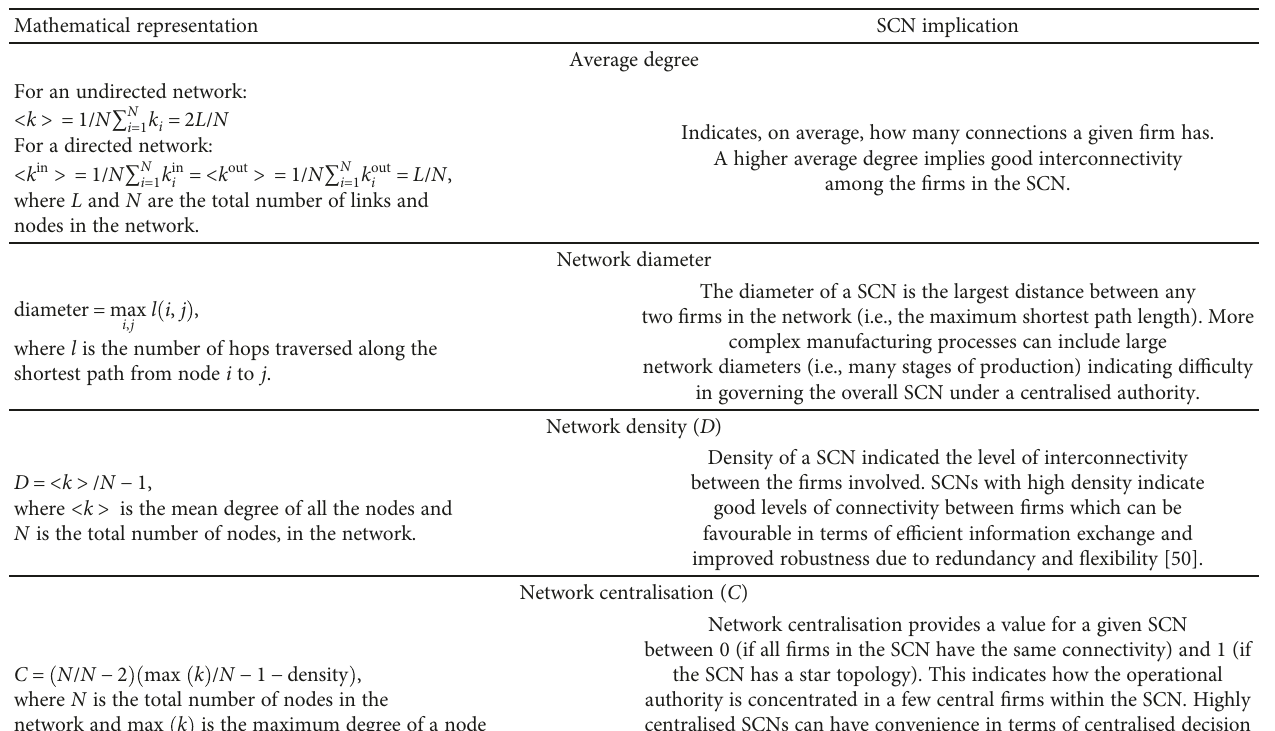
Table 5: Network-level metrics used and their SCN